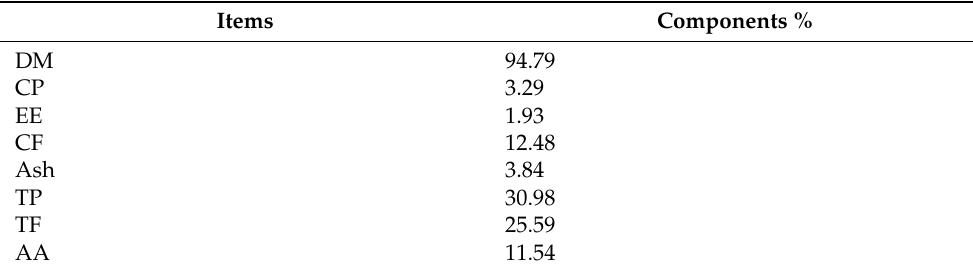
Table 2. Chemical composition of pomegranate peel powder (% on dry weight